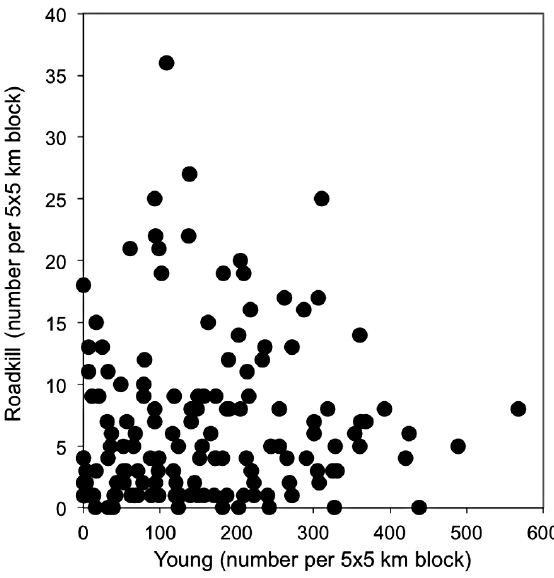
Fig. 8 . Relationship between the number of young produced per 25 km² and the number of road casualties. Contrary to expectation, there was no positive correlation (further explanation in the text).